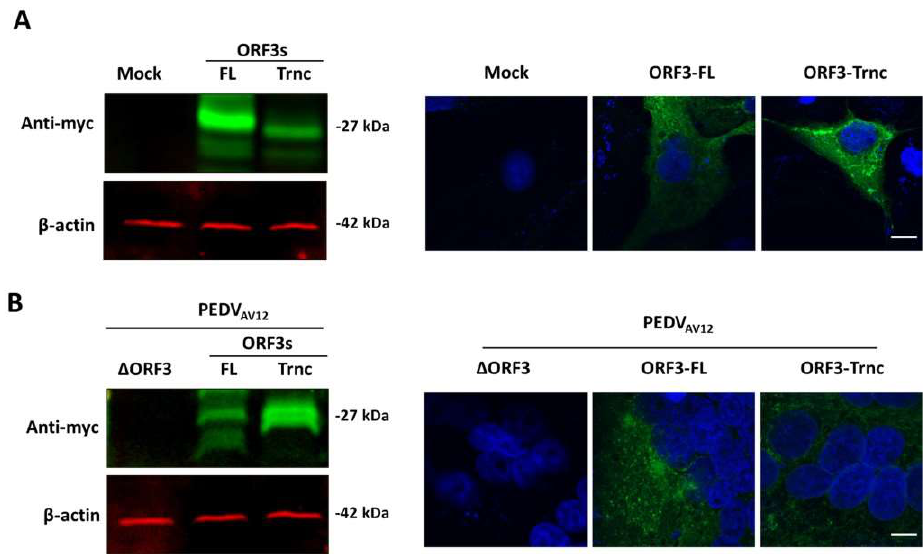
Figure 2. ORF3-myc protein expression in transfected ( A ) and infected cells ( B ). Cell lysates from transfected and infected cells were harvested and analyzed by Western blot analysis. Mock-transfected cells or PEDV AV12 _∆ORF3-infected cells were used as controls ( left panels ). VeroE6-APN cells were transfected with the plasmid expressing ORF3s-myc or infected with the recombinant viruses. ORF3-myc protein was probed by rabbit anti-myc antibodies, subsequently incubated with goat anti-rabbit IgG Alexa flour 488. Nuclei were stained with Prolong Gold Antifade Mountant with 4’,6-diamidino-2-phynyllindole (DAPI) and analyzed by confocal microscopy ( right panels ). Scale bars are 10 µm.